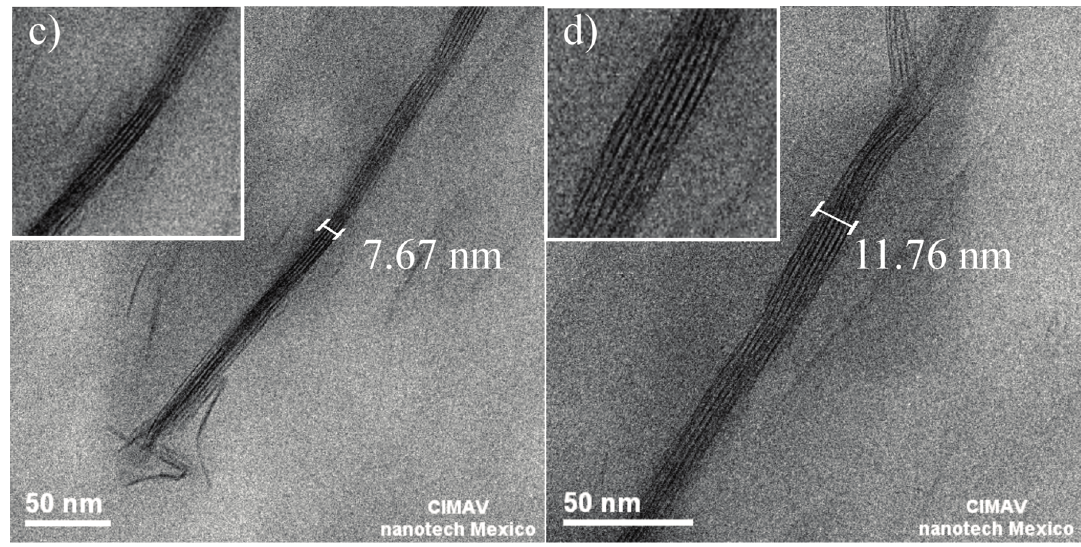
Figure 3. TEM micrographs of ( a ) PLA-A/C30B single platelet; ( b ) PLA-A/C30B three stacked platelets; ( c ) PLA-S/C30B four stacked platelets; ( d ) PLA-S/C30B eight stacked